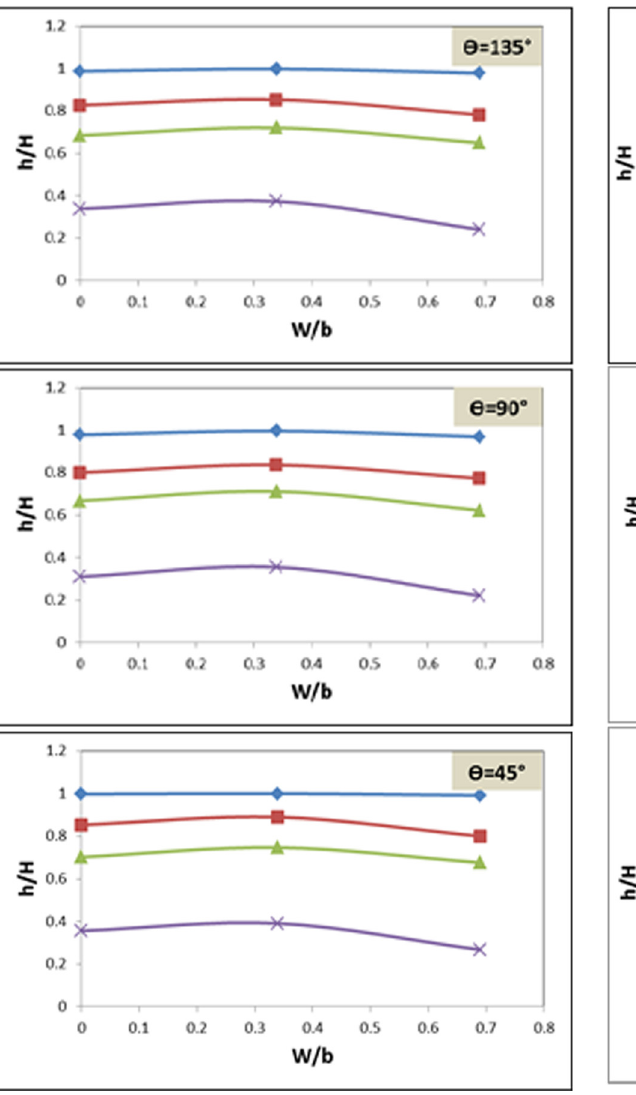
Figure 7: Change in the head pressure for di ff erent points under the dam.